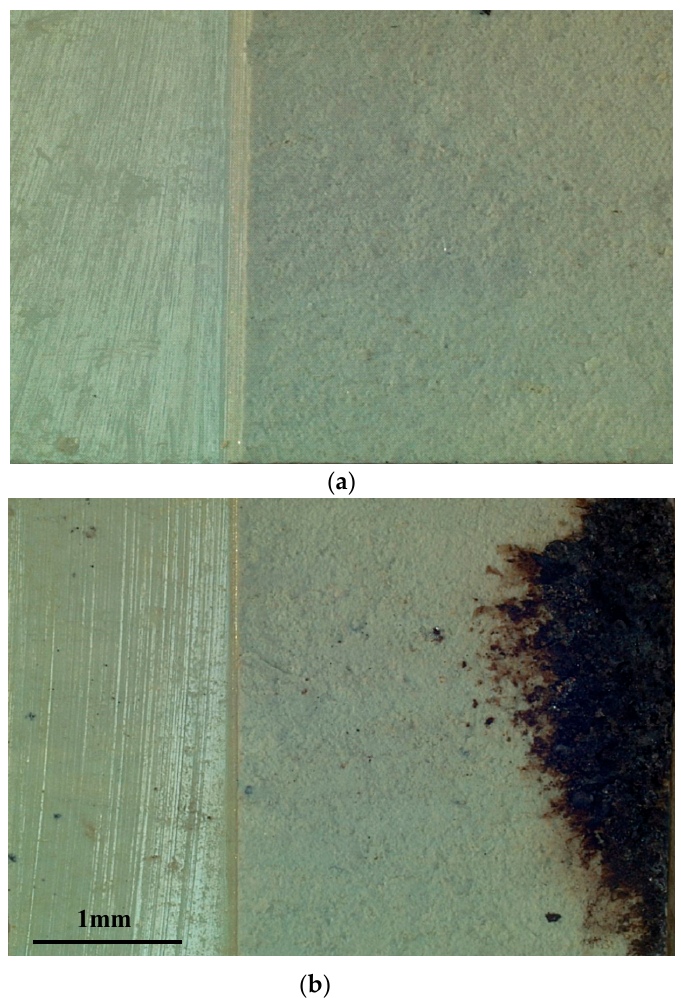
Figure 13. Fracture morphologies under ( a ) the pure mechanical loading and ( b ) the combined electrical and mechanical loading.